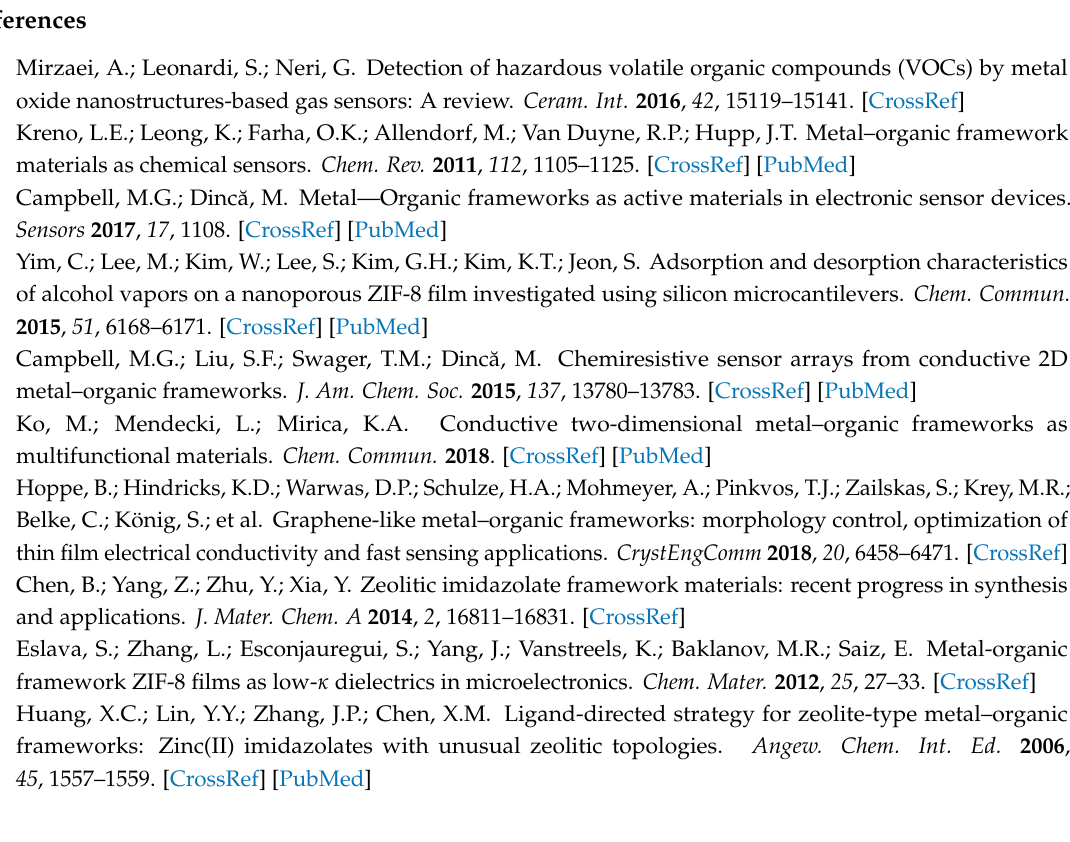
Figure S11 : Comparison ∆ C versus temperature of the bare device in vacuum for single and fast temperature steps, Figure S12 : Fabrication process flowchart MIM capacitor, Figure S13 : Capacitance versus frequency of MIM capacitor at different temperatures, Figure S14 : Dielectric constant and capacitance of MIM capacitor at different temperatures, Figure S15 : FEM Modelling of IDE capacitor, Figure S16 : ∆ C versus temperature of the bare device obtained by FEM model, Figure S17 : Comparison of ∆ C versus temperature of the bare device obtained by the calibration experiments, Figure S18 : Capacitive response for exposure to methanol concentration of 5000ppm at (Figure S18a) 30 ◦ C, (Figure S18b) 40 ◦ C, (Figure S18c) 50 ◦ C, Capacitive response after SiN x isolation layer capacitance calibration (Figure S18d) 30 ◦ C, (Figure S18e) 40 ◦ C, (Figure S18f) 50 ◦ C, Final Capacitive response ( ∆ C ) after baseline drift calibration (Figure S18g) 30 ◦ C, (Figure S18h) 40 ◦ C, (Figure S18i) 50 ◦ C, Figure S19 : Capacitive response for exposure to water vapor concentration of 5000 ppm at (Figure S19a) 30 ◦ C, (Figure S19b) 40 ◦ C, (Figure S19c) 50 ◦ C, Capacitive response after SiN x isolation layer capacitance calibration (Figure S19d) 30 ◦ C, (Figure S19e) 40 ◦ C, (Figure S19f) 50 ◦ C, Final Capacitive response ( ∆ C ) after baseline drift calibration (Figure S19g) 30 ◦ C, (Figure S19h) 40 ◦ C, (Figure S19i) 50 ◦ C, Figure S20 : Stability test with ZIF-8 MOF to Methanol concentration of 5000 ppm, Figure S21 : Temperature dependent capacitance response to 5000 ppm methanol measured over three weeks, Figure S22 : Time-dependent adsorption kinetic fit for exposure to methanol concentration of 5000 ppm at (Figure S22a) 20 ◦ C, (Figure S22b) 30 ◦ C, (Figure S22c) 40 ◦ C, (Figure S22d) 50 ◦ C, Figure S23 : Time-dependent desorption kinetic fit for exposure to methanol concentration of 5000 ppm at (Figure S23a) 20 ◦ C, (Figure S23b) 30 ◦ C, (Figure S23c) 40 ◦ C, (Figure S23d) 50 ◦ C, Table S1 : Summary of material parameters for FEM analysis, Table S2 : Summary of design parameters for FEM analysis, Table S3 : Table of kinetic parameters and regression co-efficient for adsorption curves, Table S4 : Table of kinetic parameters and regression co-efficient for desorption